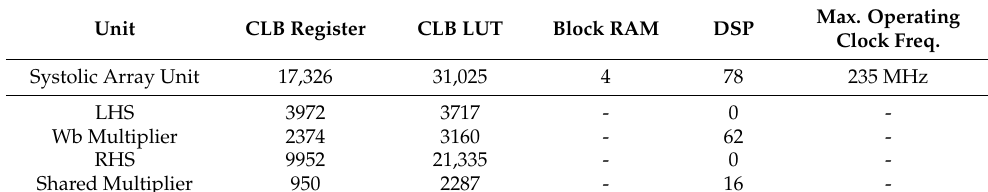
Table 1. Implementation results based on the Xilinx Zynq UltraScale+ FPGA device.